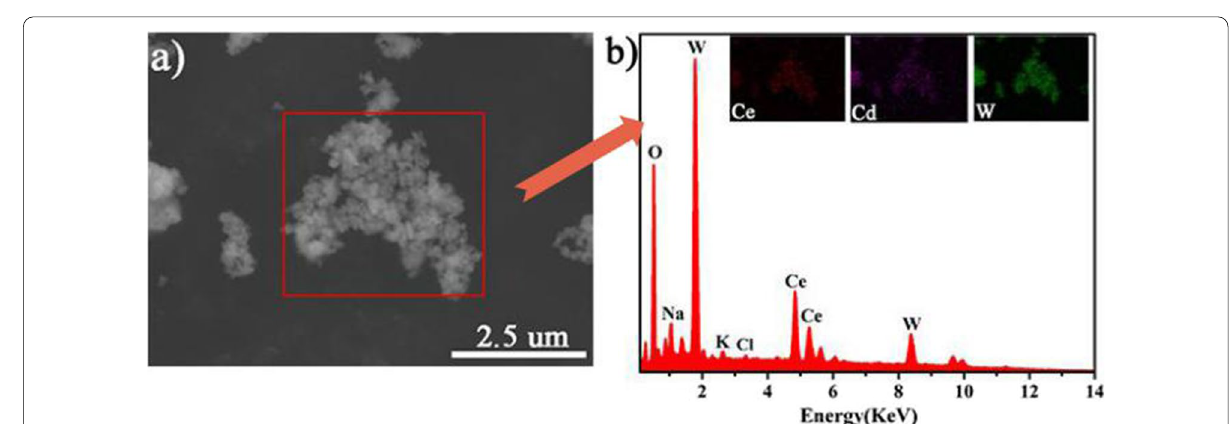
Fig. 7 Corresponding element mappings and EDX of CeCdW 12